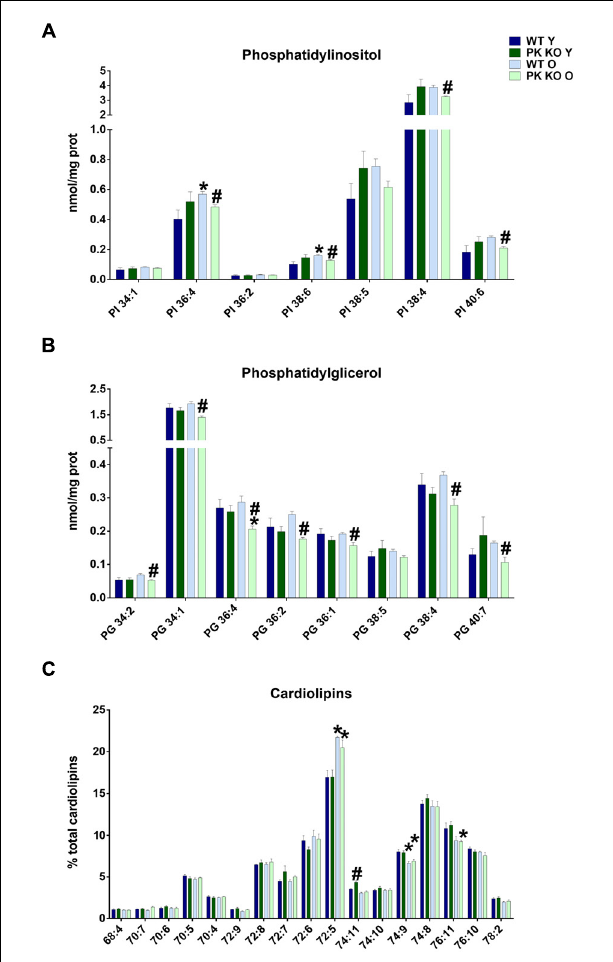
FIGURE 3 | PI, PG, and Cardiolipin’s species detected in brain’s mitochondria and changes due to aging and Parkin loss. Aging decreases PG and PI levels in PK-KO mice and cardiolipin’s remodeling both in WT and PK-KO (A) Levels of more abundant PI species. (B) Levels of PG species detected. Data are expressed an nmol/mg prot for each lipid specie (C) Cardiolipin’s unsaturation in brain’s mitochondria. Data are expressed as percentage of each lipid specie levels versus total levels of cardiolipins detected per preparation. Graphs represent the mean ± SEM. Statistical analysis was performed by One Way ANOVA. n = 4 for lipidomic analysis. ∗ p < 0.05 due to aging. # p < 0.05 due to parkin